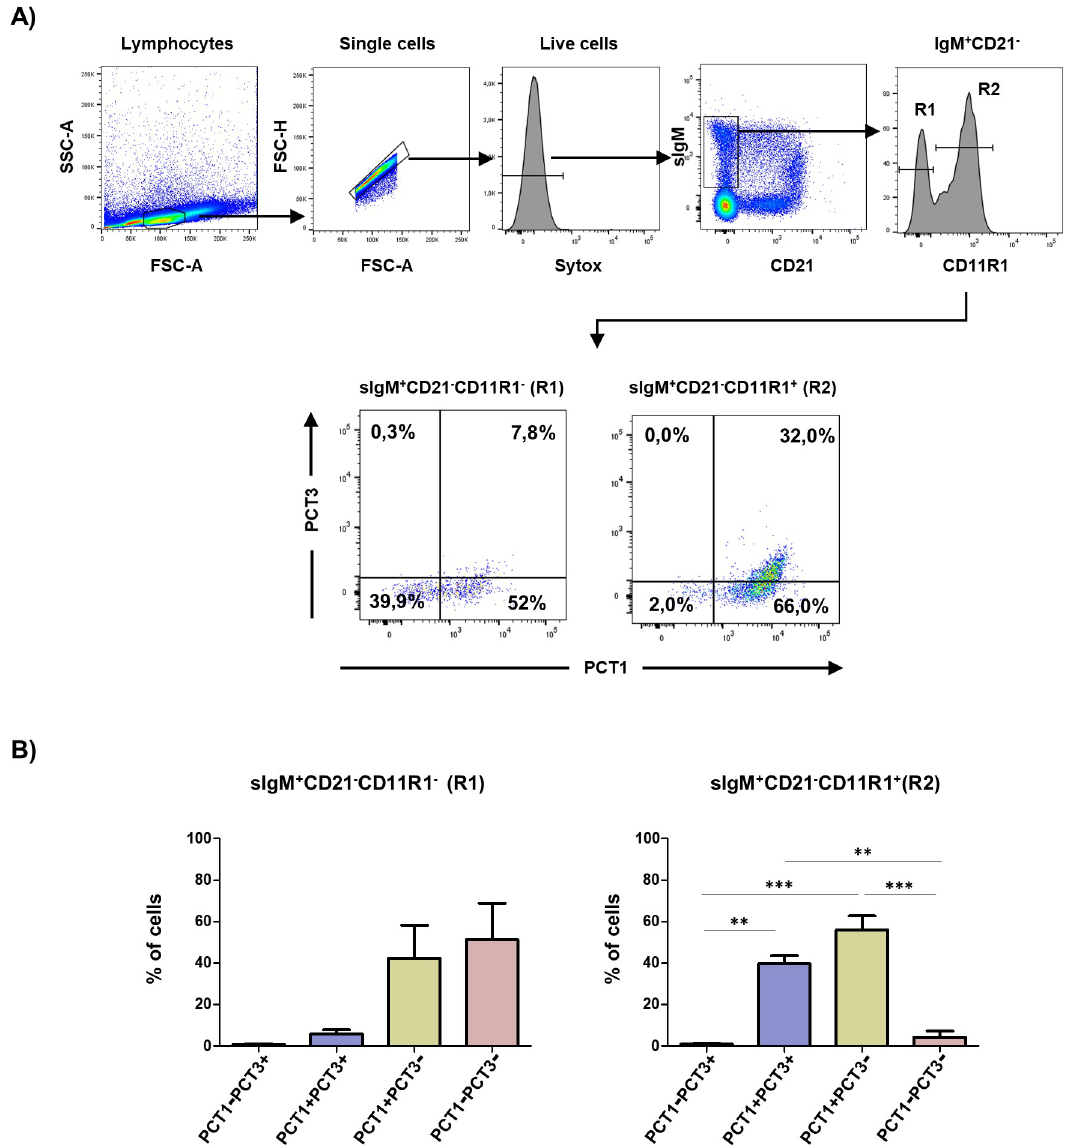
PCT1 and PCT3 staining reveals the existence of further heterogeneity within the popula- tions of porcine sIgM+ effector/memory B cells and plasmablasts, allowing to discriminate three main subsets in each of them whose developmental relationship remains to be investi- gated. These subsets may also differ in the threshold of activation which may be regulated by the level of expression of CD200R1 and CD200R1L. Besides, the level of sIgM is higher in the PCT1 + than in the PCT1 - effector/memory cells, which may be related to the subsets